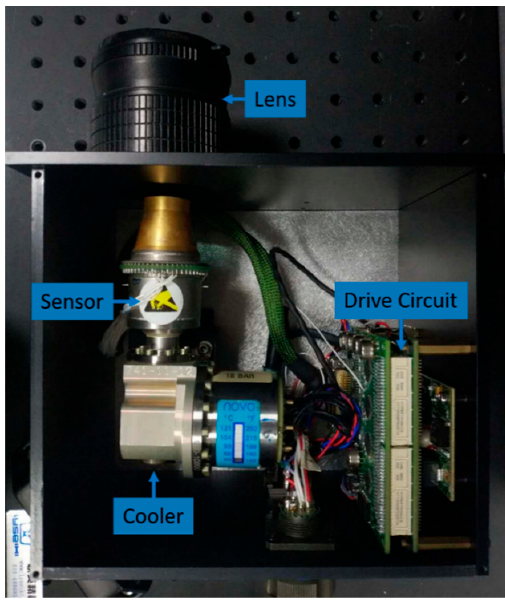
Figure 8. The imaging structure of our infrared system. MARS-VLW-RM4 from Sofradir Company is the infrared image sensor of 320 × 256 resolution. The lens is suitable for Very Long-Wave band of f = 60 mm and F = 2.0 from Lenstech Company in Beijing, China.